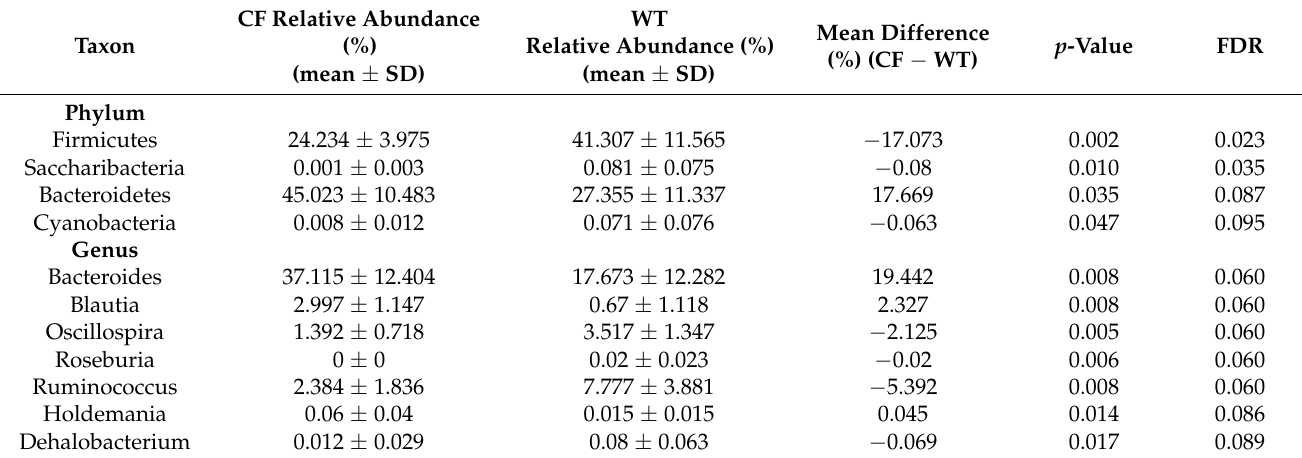
Table 3. Predicted KEGG orthology terms with a significantly different abundance between CF and WT groups.